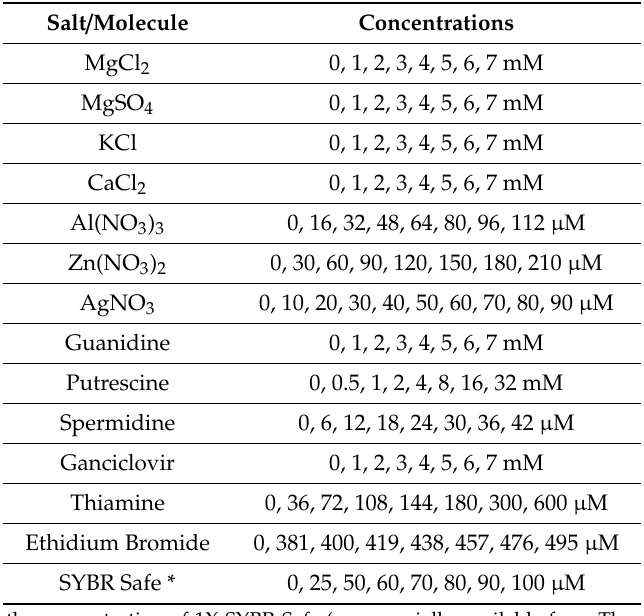
Table 1. Salts / molecules and their concentrations used in this